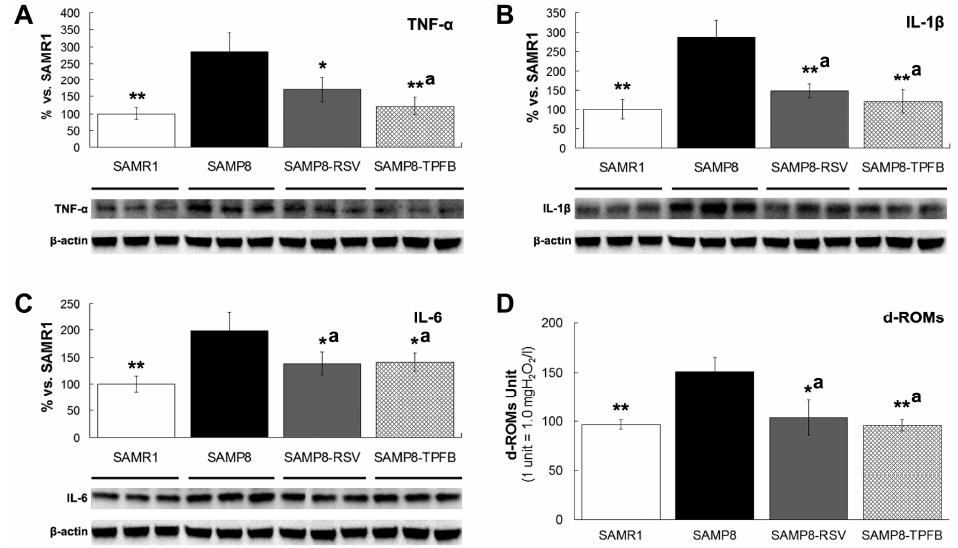
Figure 4. TPFB significantly decreased the expression of proinflammatory cytokines in SAMP8 mice brains and reduced oxidative levels in SAMP8 mice sera. ( A ) TNF- α ; ( B ) IL-1 β ; and ( C ) IL-6 were measured by Western blots; ( D ) Serum oxidative levels were measured by derivatives of reactive oxygen metabolites (d-ROMs) test. Compared to SAMR1 ( n = 10), SAMP8 mice ( n = 5) produced significantly more TNF- α , IL-1 β , and IL-6 in their brains and d-ROMs in their sera at the age of 12 months, whereas TPFB (50 mg/kg·day, n = 7) and resveratrol (RSV, 150 mg/kg·day, n = 7) significantly restored these values to the normal range of SAMR1. Data are expressed as mean ± SEM. * p < 0.05, ** p < 0.01 vs. SAMP8 group; a Non-significant vs. SAMR1 group.